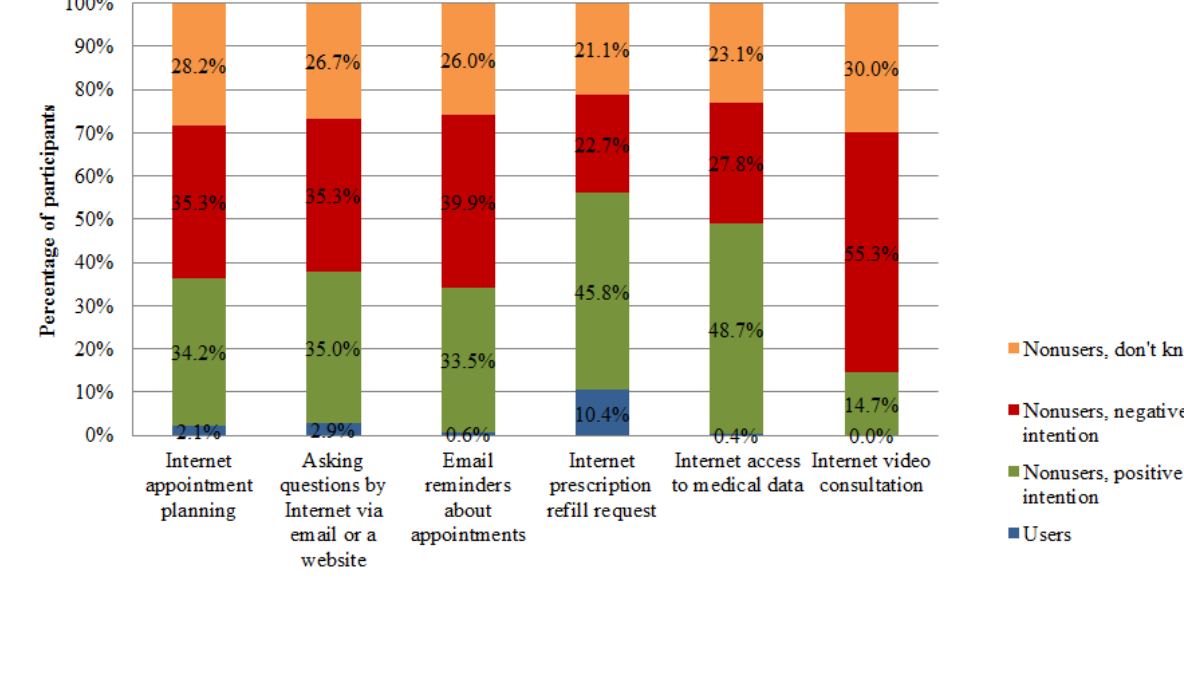
Figure 2. Percentage of participants who had used the Internet care service in the past year, and participants’ intention toward the use of the Internet